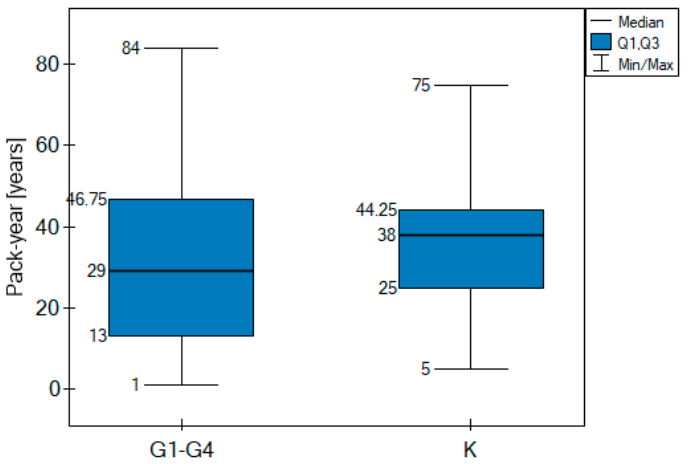
Figure A2. Analysis of the group of patients and the control group in terms of burned pack-years.